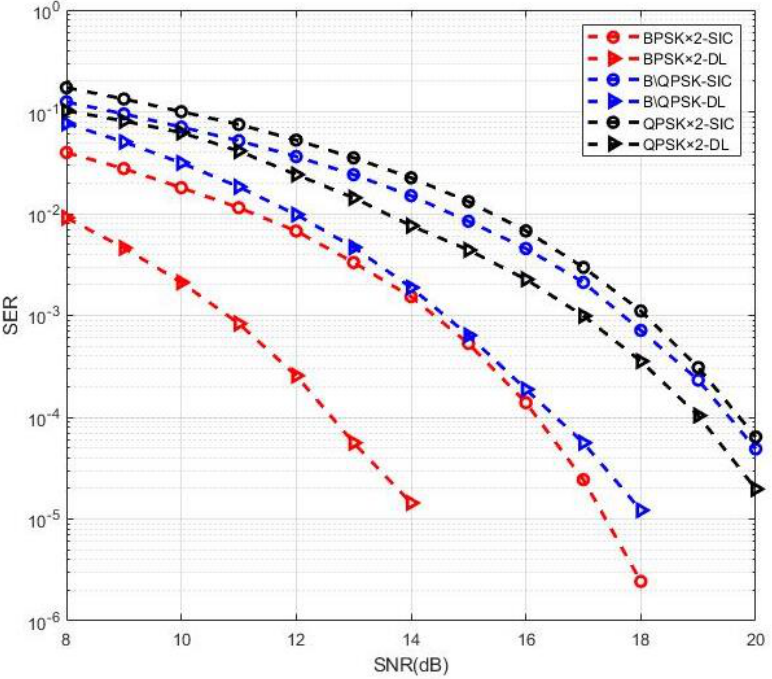
Figure 11. Performance comparison of MIMO-NOMA-DL and